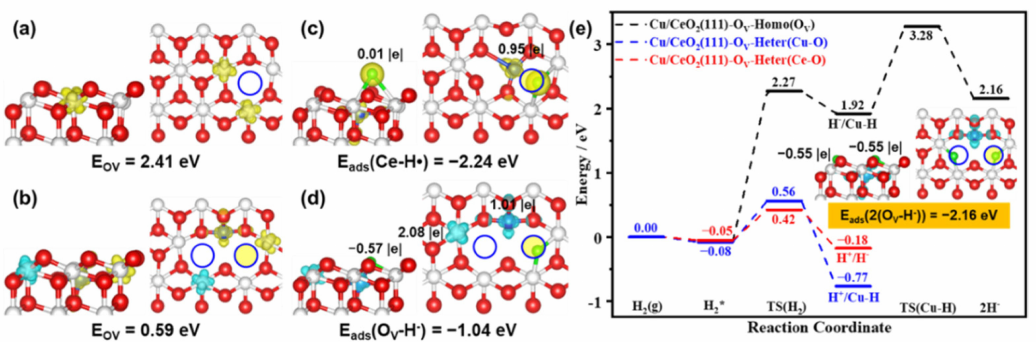
Figure 5. Calculated structures (left: side view; right: top view) of the ( a ) reduced CeO 2 (111) with one surface oxygen vacancy and ( b ) reduced Cu/CeO 2 (111) with one inherent surface oxygen vacancy and an extra surface oxygen vacancy. Calculated structures (left: side view; right: top view) of a single H at the oxygen vacancy sites of the ( c ) Cu/CeO 2 (111) and ( d ) reduced Cu/CeO 2 (111)-O V surfaces. ( e ) Calculated energy profiles of homolytic (Homo) and heterolytic (Heter) H 2 dissociation on the Cu/CeO 2 (111)-O V surface. The unfilled blue circle represents the surface oxygen vacancy, and the blue circle filled with yellow represents the inherent surface oxygen vacancy on the Cu/CeO 2 (111). The spin density distributions are illustrated in yellow and blue, and the surface oxygen vacancy formation energies are also